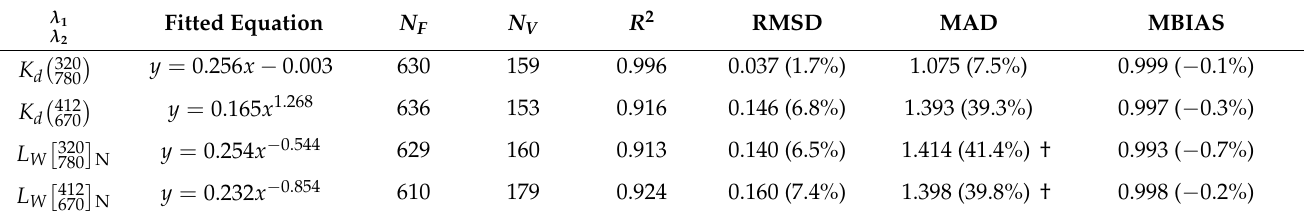
Table 3. The band-ratio K d ( λ ) and algorithms following the formatting and reporting procedures established for N Table 1. To save table space, the λ 1 notation indicates the two bands in the ratio with λ 1 as the numerator term and λ 2 as the λ 2 denominator term, i.e., K